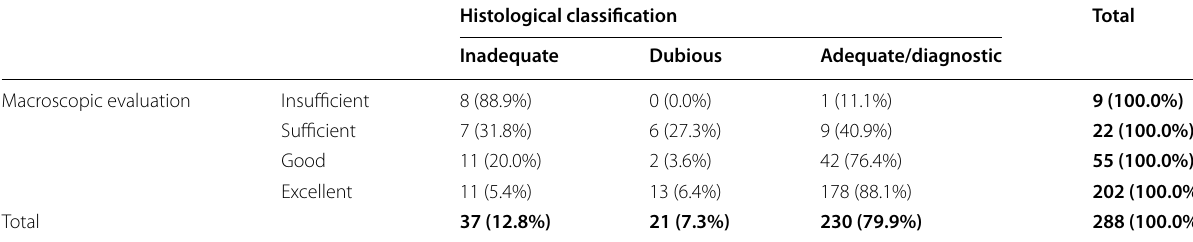
Table 6 Macroscopic evaluation versus histologic evaluation cross tabulation